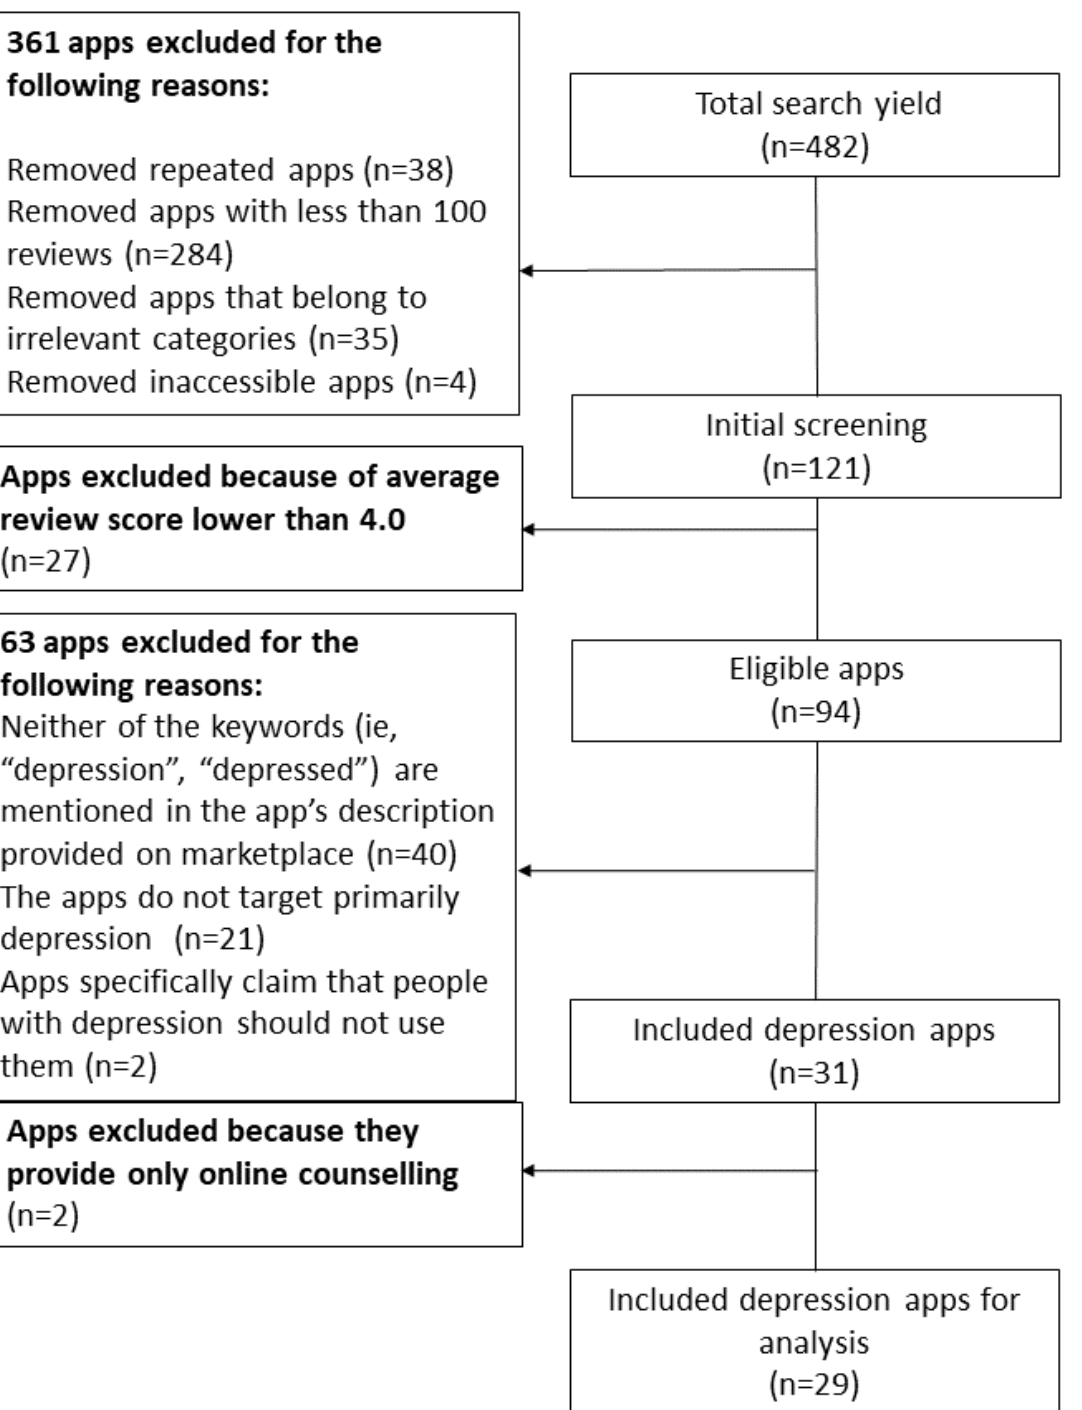
Figure 1. App extraction